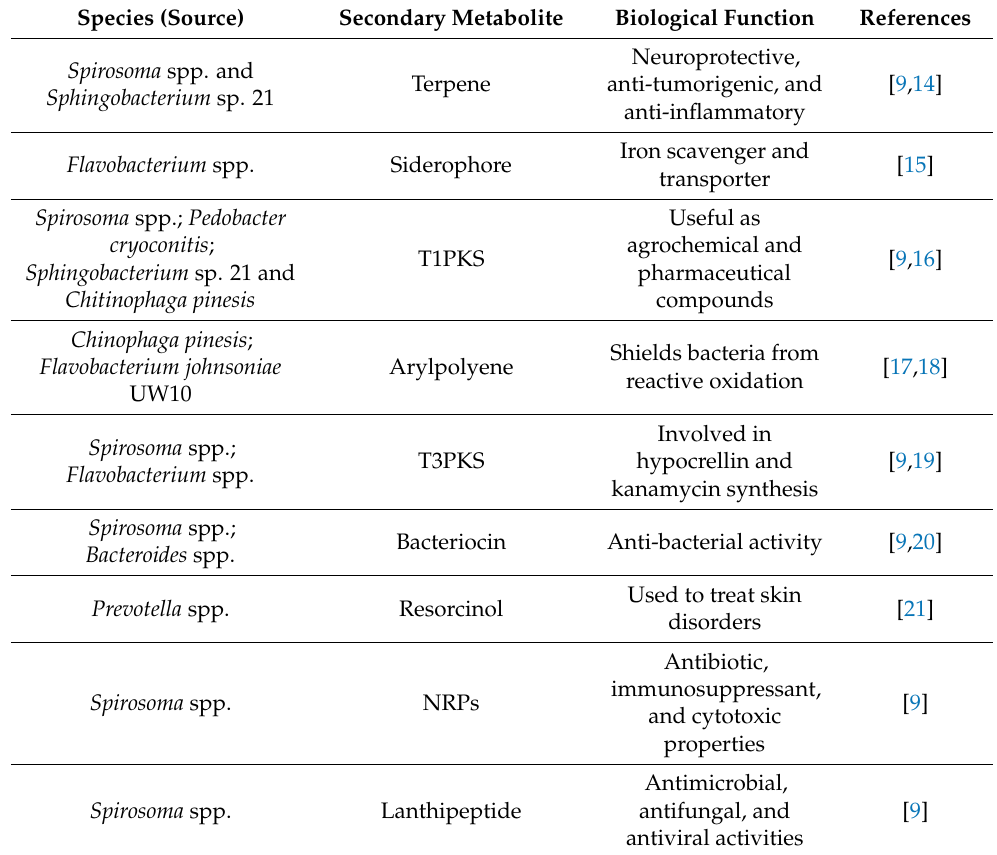
Table 1. Secondary metabolites produced by Bacteroidetes species and their biological